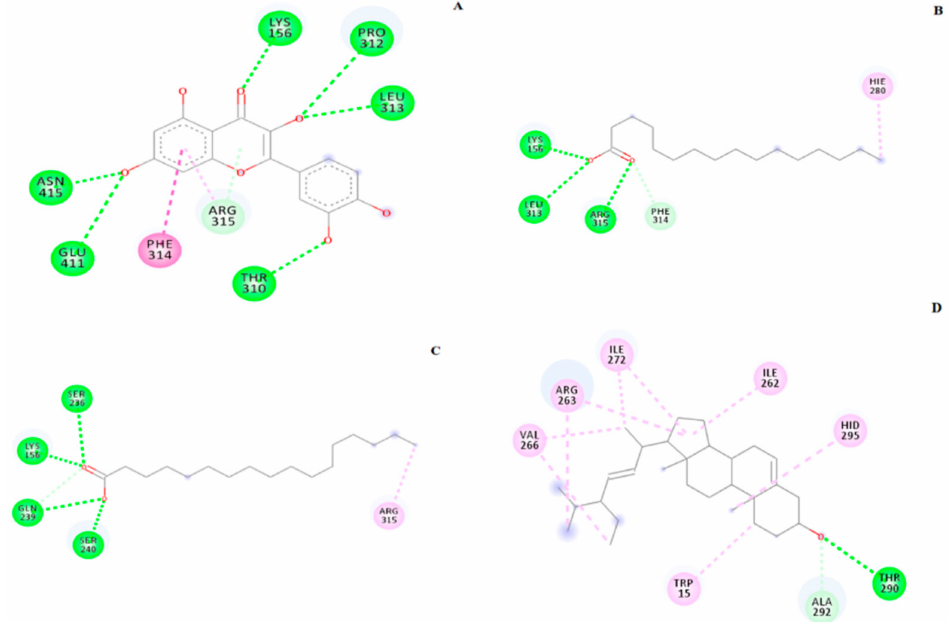
Figure 6. The 2D diagram showing the interaction between the protein residues and the inhibitors. ( A )